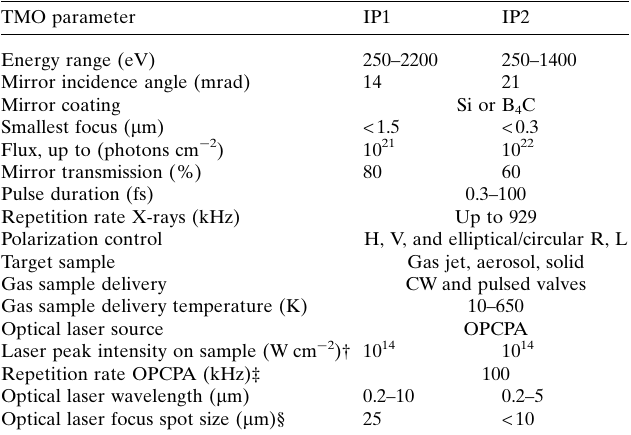
Table 2 Parameters and capabilities of the TMO